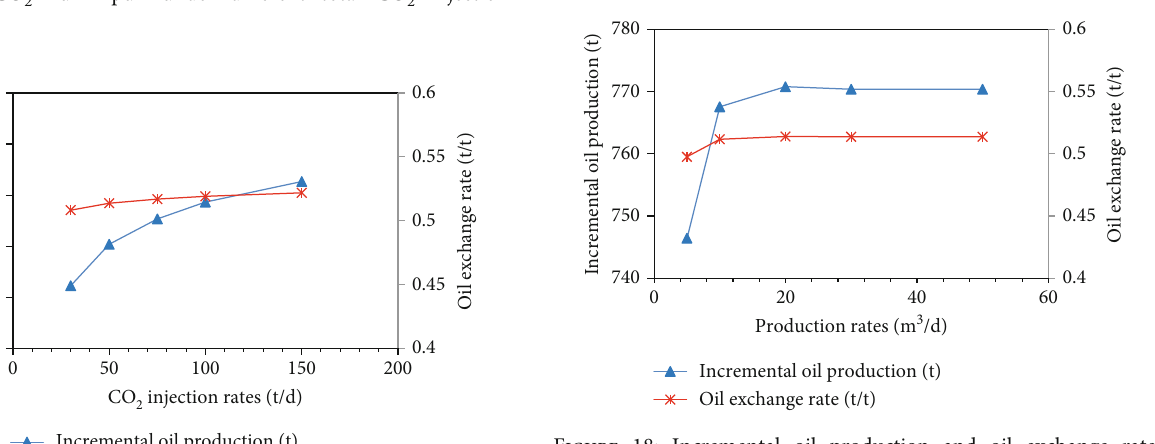
injection rates. 2